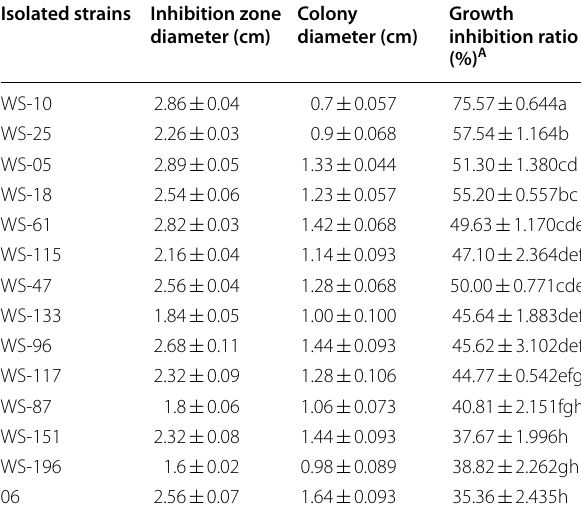
Table 2 Antagonistic effect of selected Bacillus sp.